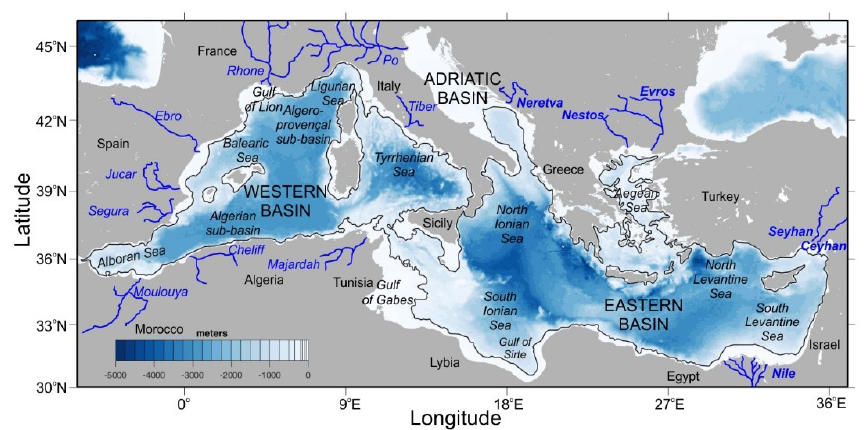
Figure 1. Map of the Mediterranean Sea showing the main basins, sea regions, surrounding countries and major rivers. Bathymetric data were obtained from ETOPO1 (Amante and Eakins, 2009). The black contour indicates the 200m isobath, the limit of coastal waters as defined in the present